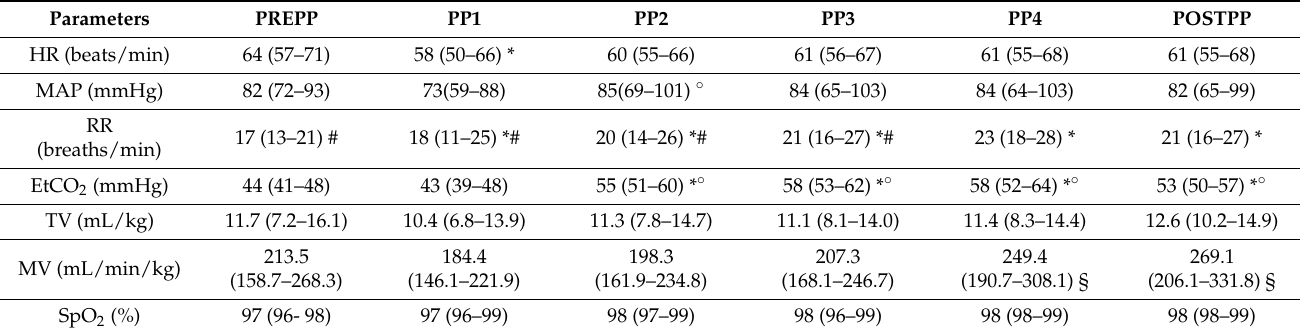
Table 3. Mean values and 95% CI of the values of heart rate (HR), mean arterial pressure (MAP), respiratory rate (RR), end tidal carbon dioxide concentration (EtCO 2 ), tidal volume (TV), minute volume (MV), and peripheral hemoglobin oxygen saturation (SpO 2 ) of the animals included in the study.